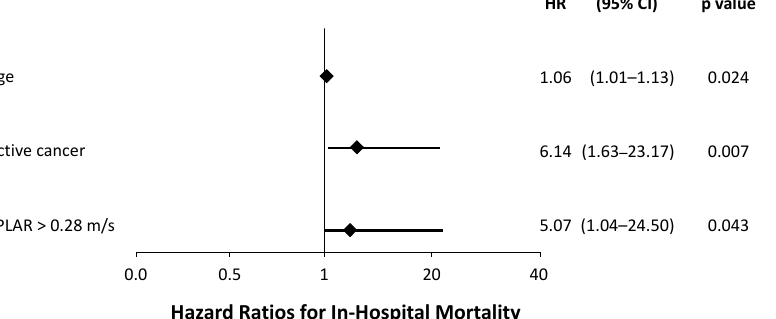
Figure 3. Multivariate Cox regression analysis for independent predictors of in-hospital death. A